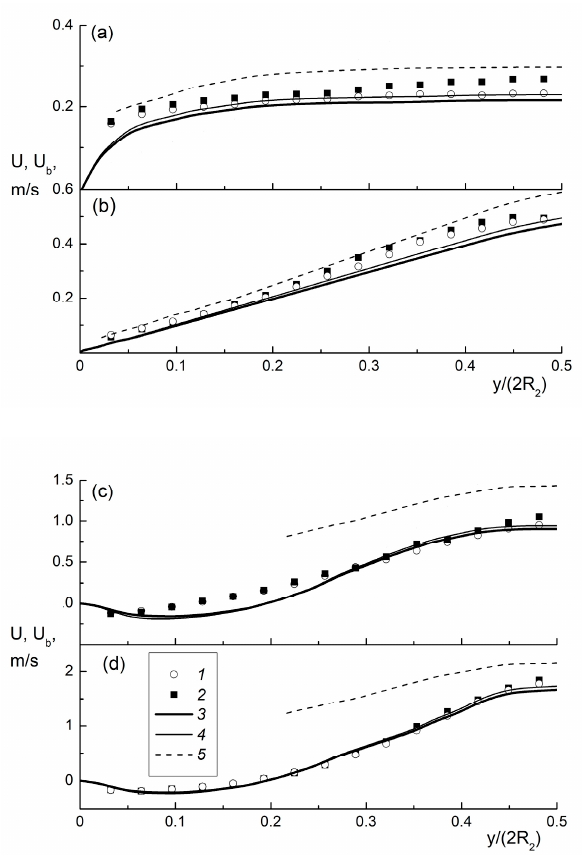
Figure 6. The distributions of mean axial fluid and gas bubbles velocities at x / H = 16 ( a ), 12 ( b ), 8 ( c ) and 4 ( d ). Re H = 2.09 × 10 4 , d = 1.7 mm, β = 3.5%. Points and curves are authors’ measurements and simulations respectively. 1 , 3— β = 0 (single-phase fluid flow), 2 , 4— carrier fluid phase ( β = 3.5%), 5— gas bubbles ( β = 3.5%).